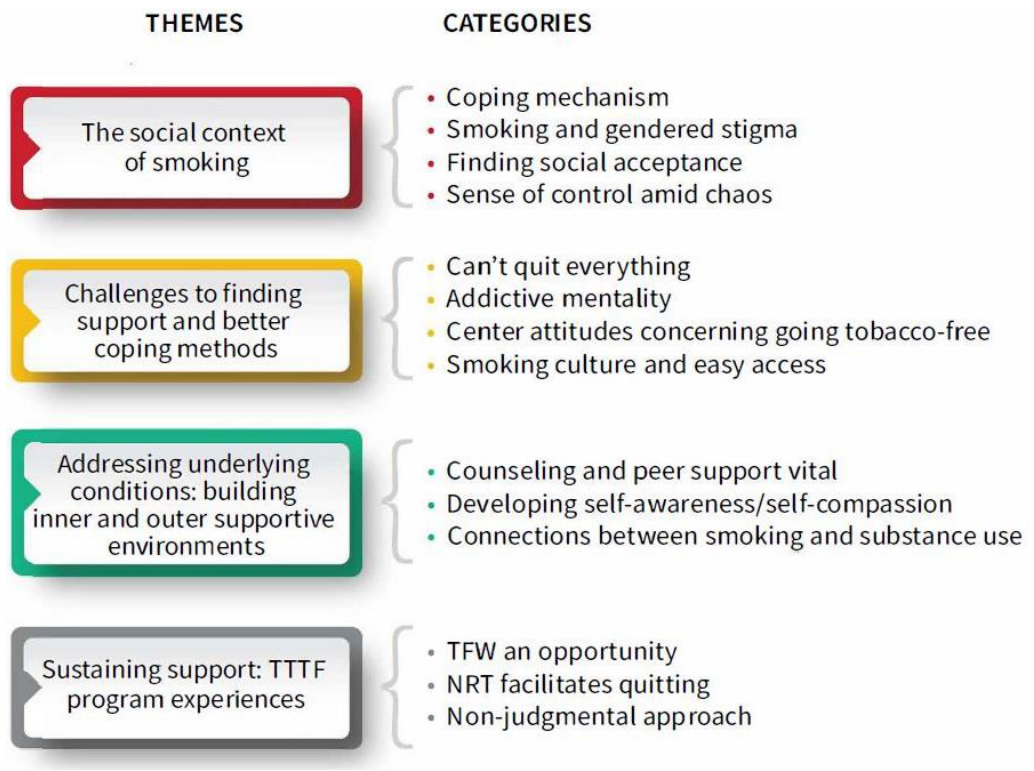
Figure 1. The meanings of smoking and women’s needs for quitting.